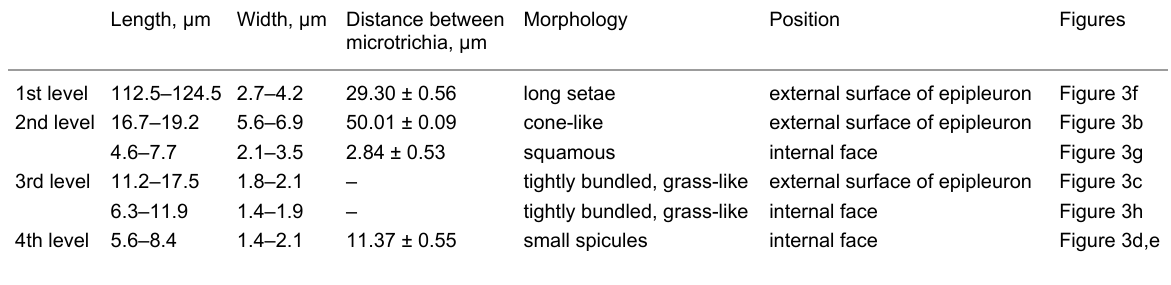
Table 1: Morphological parameters of microtrichia of elytra of H. axyridis on